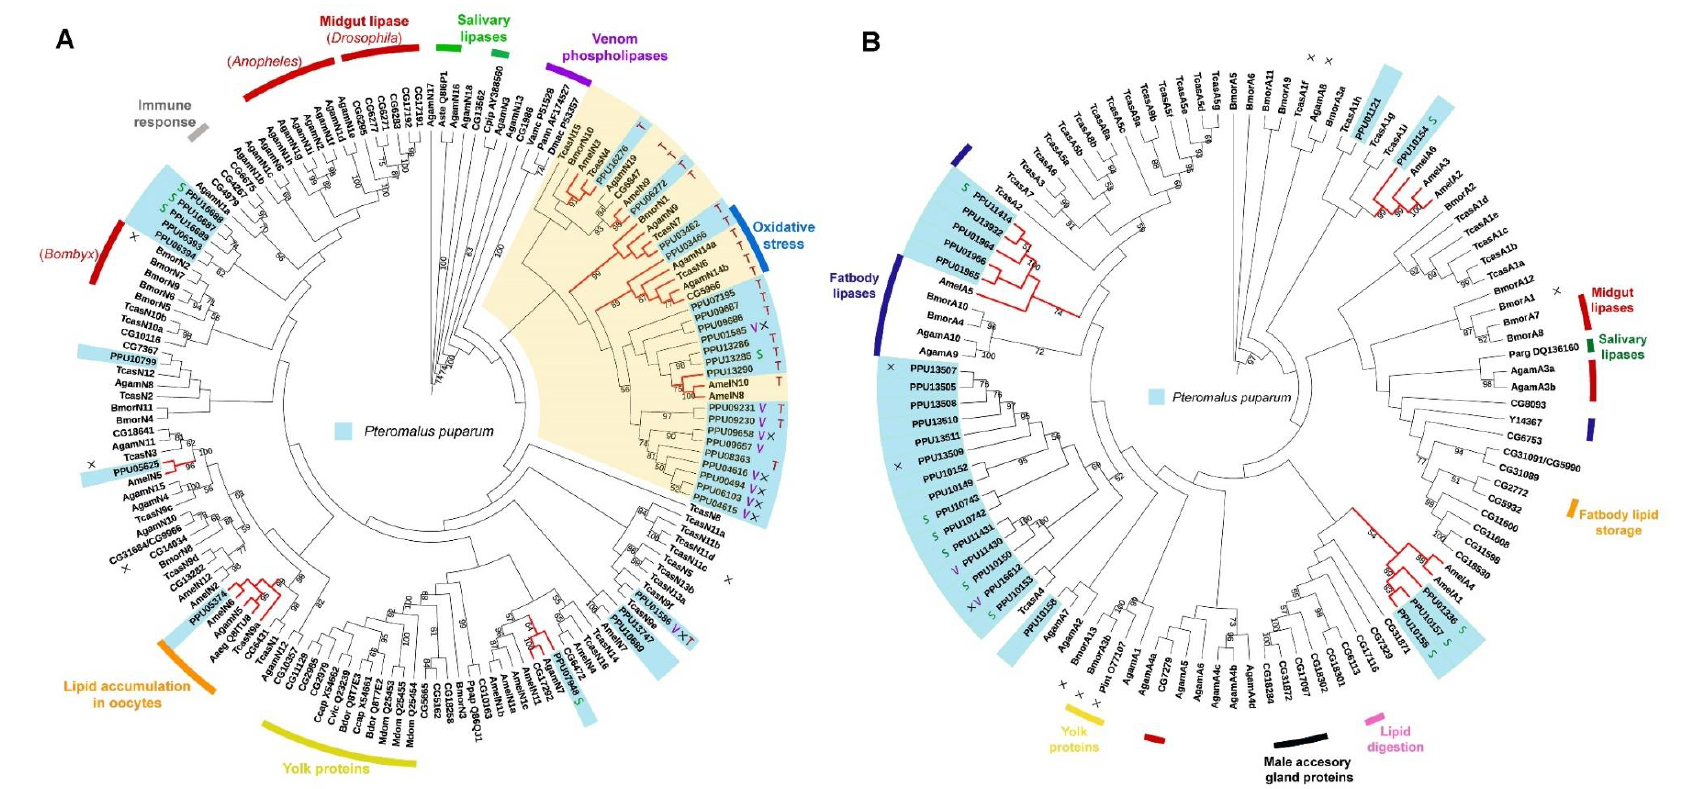
Figure 4. Phylogenetic trees of lipase proteins from P. puparum and other recognized insect lipases. ( A ) Neighbor-joining tree of neutral lipases. The yellow clade includes a cluster of lipases with predicted TAG hydrolytic activity. ( B ) Neighbor-joining tree of acid lipases. Lipases with especially high expression in venom glands and salivary glands are represented as letters V and S, respectively. Indications were used to display whether the proteins are catalytically inactive ( × ) or have putative TAG hydrolytic activity (T) predicted by the lengths of their respective β 9 loops and lids. Branches in red represent the orthologues of P. puparum lipases. All predicated lipase proteins were displayed in a light blue box. Only bootstrap values (from 1000 replicates) over 50 were displayed as text. The functions or predicted functions of the lipases were presented at the outer circle in different colors.